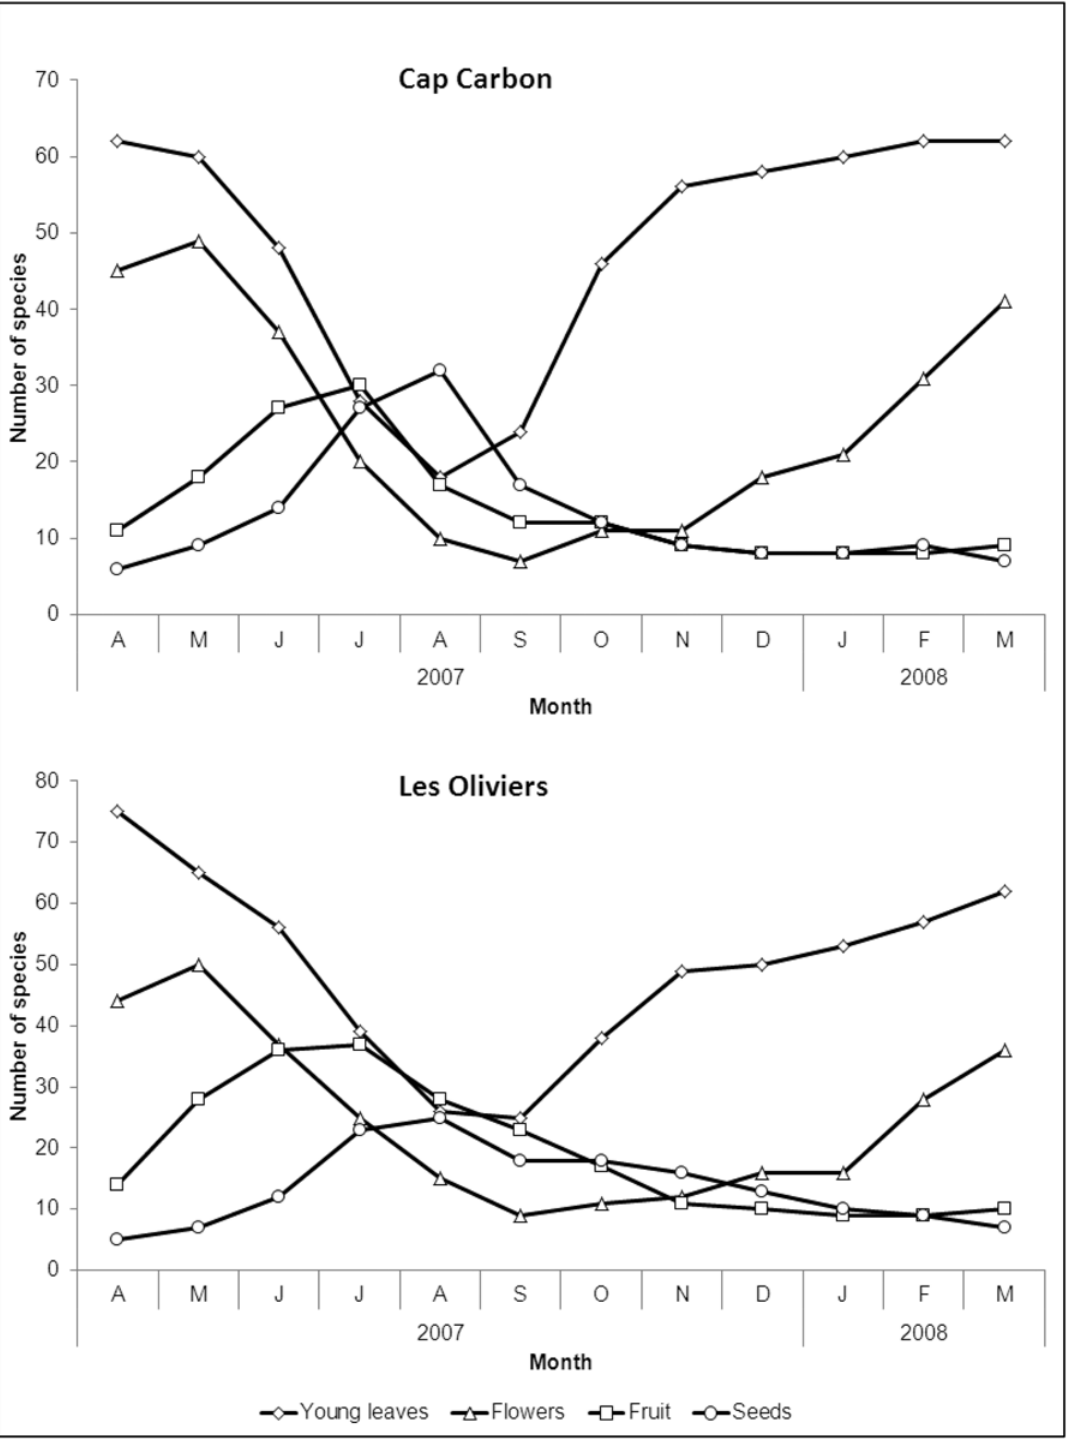
Fig 2. Number of available plant species in each phenological stage at “ Les Oliviers ” (peri-urban) and “ Cap Carbon ” (non-urban) sites.